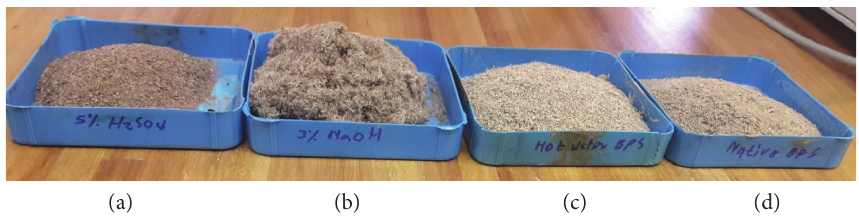
Figure 1: Banana pseudostem before and after pretreatment. (a) 5% H